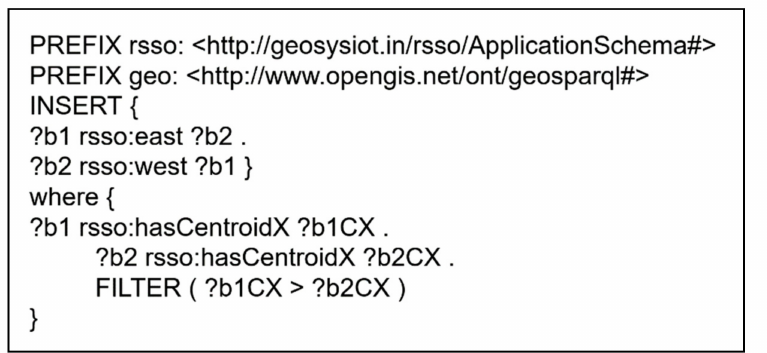
Figure 9. GeoSPARQL query depicting inferencing of East and West directional relationship. North-East Direction : A region a is to the North-East of region b if a is to the North of b and a to the East of b